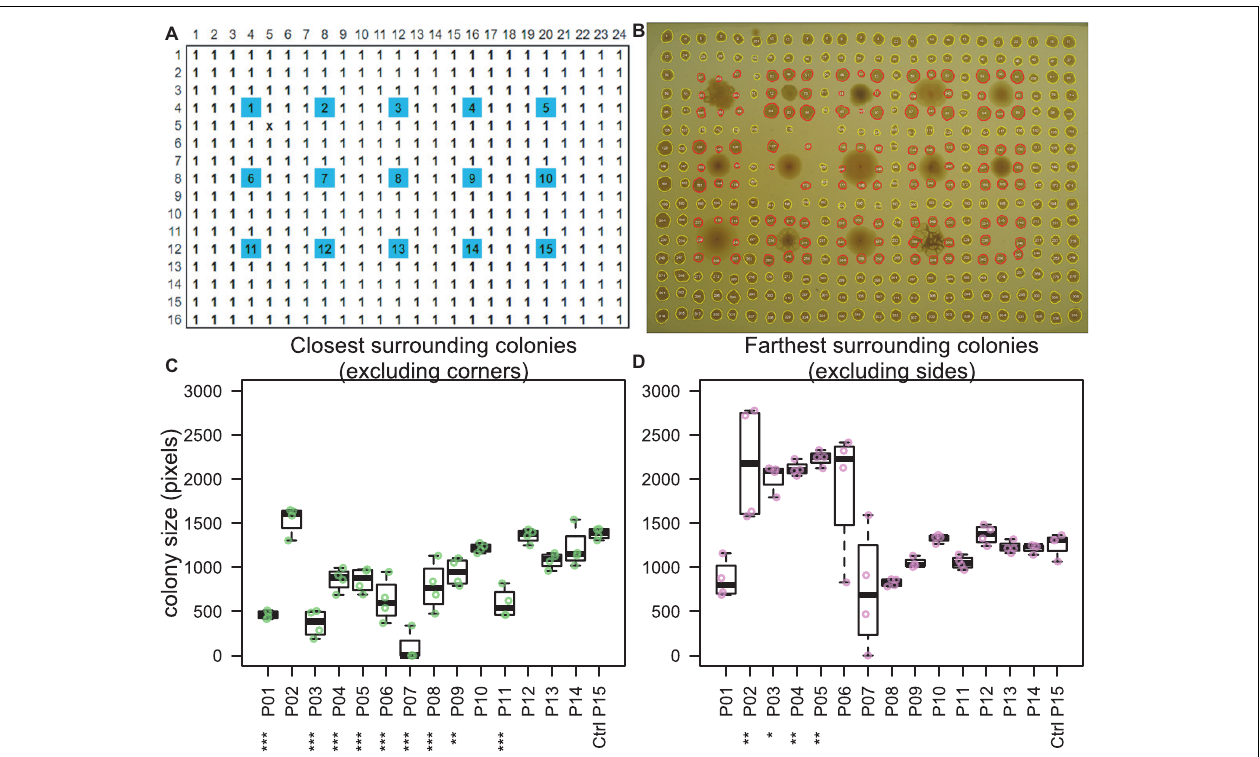
FIGURE 2 | Colony interaction screening. (A) Fourteen Pseudomonas “effector” strains (spots #1–14) and one uninoculated control medium (spot #15) were printed from liquid cultures onto an agar plate (blue). After 2 days of incubation, the interaction strain, P. stutzeri RCH2 (#1) was printed in all other positions (white). (B) Image taken at 6 days total incubation time indicated inhibited growth of P. stutzeri RCH2 around strains 1 (self), 3, 4, 5, 6, 7, 8, 9, and 11. (C,D) P. stutzeri RCH2, the interaction strain, colony size was used to evaluate which effector strains had a significant (ANOVA, Dunnett’s test, *** p < 0.001, ** p < 0.01, * p < 0.05) effect on the growth of the neighboring RCH2 colonies. One effector strain (#2), N1B4, with the largest mean surrounding colony area and which did not inhibit RCH2, was selected for further morphological and metabolic interaction with RCH2. When comparing all surrounding colonies, only #7 was significantly different from control ( Supplementary Figure 2